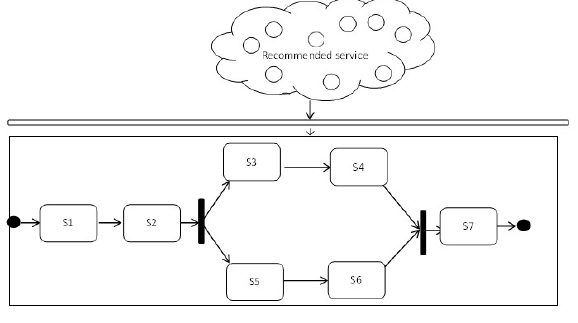
Fig. 3. Classification of Service Recommendation Approaches